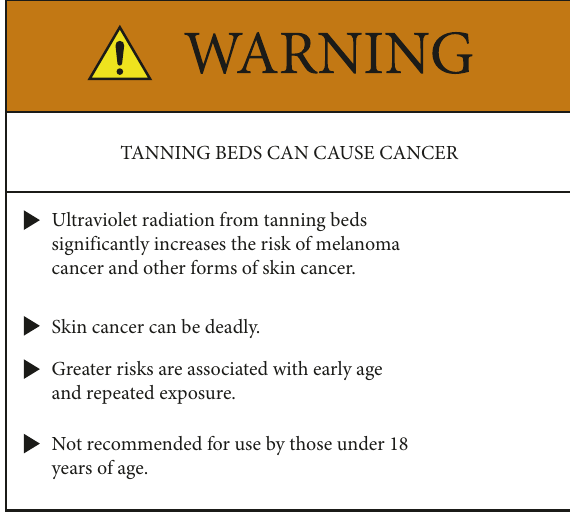
Figure 1: Warning label shown to tanning bed users.